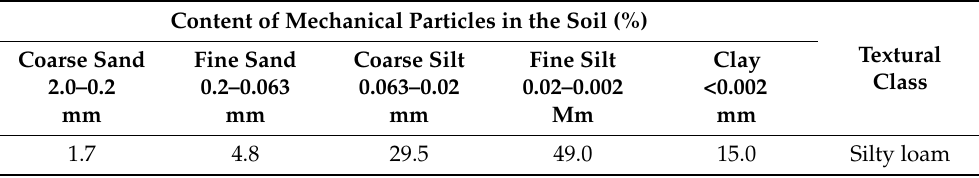
Table 2. Mechanical composition of the soil used in the